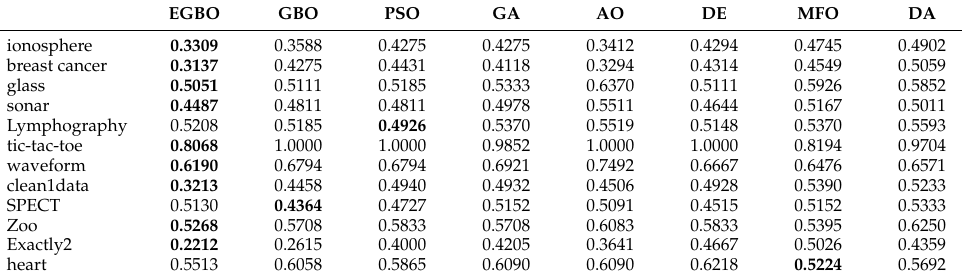
Table 10. Ratios of the selected features.